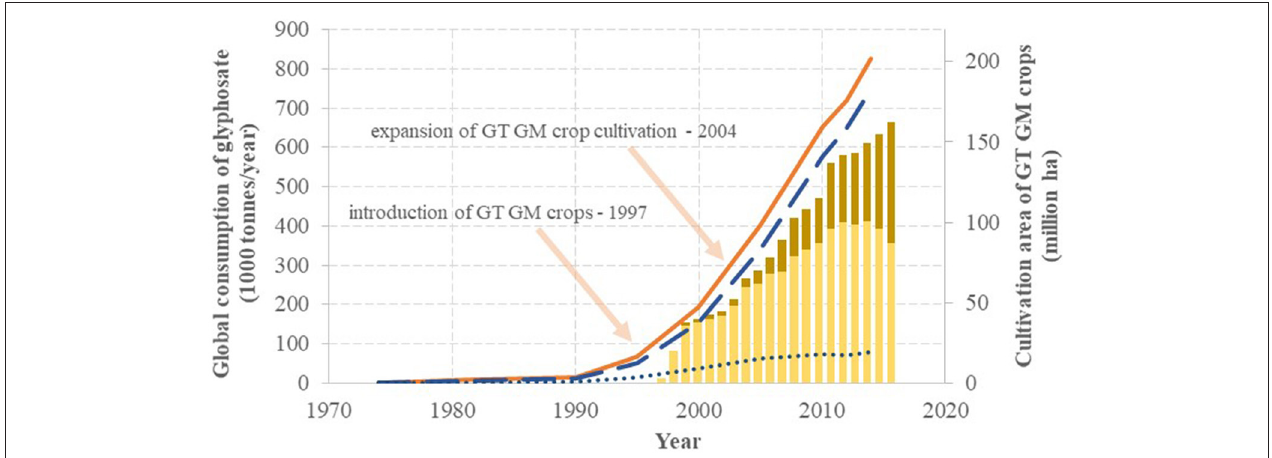
FIGURE 1 | The global annual turnover of glyphosate and the intensity of the cultivation of glyphosate-tolerant (GT) genetically modified (GM) crops: agricultural ( slashed line ), non-agricultural ( dotted line ) and overall ( solid line ) use of glyphosate, along with cultivation of single trait ( light columns ) and multiple traits ( dark columns ) GT GM crops. On the basis of Székács and Darvas (2012), Benbrook (2016), Cuhra et al. (2016), Myers et al. (2016) and the updated dataset of the International Service for the Acquisition of Agri-biotech Applications ( James, 2015).